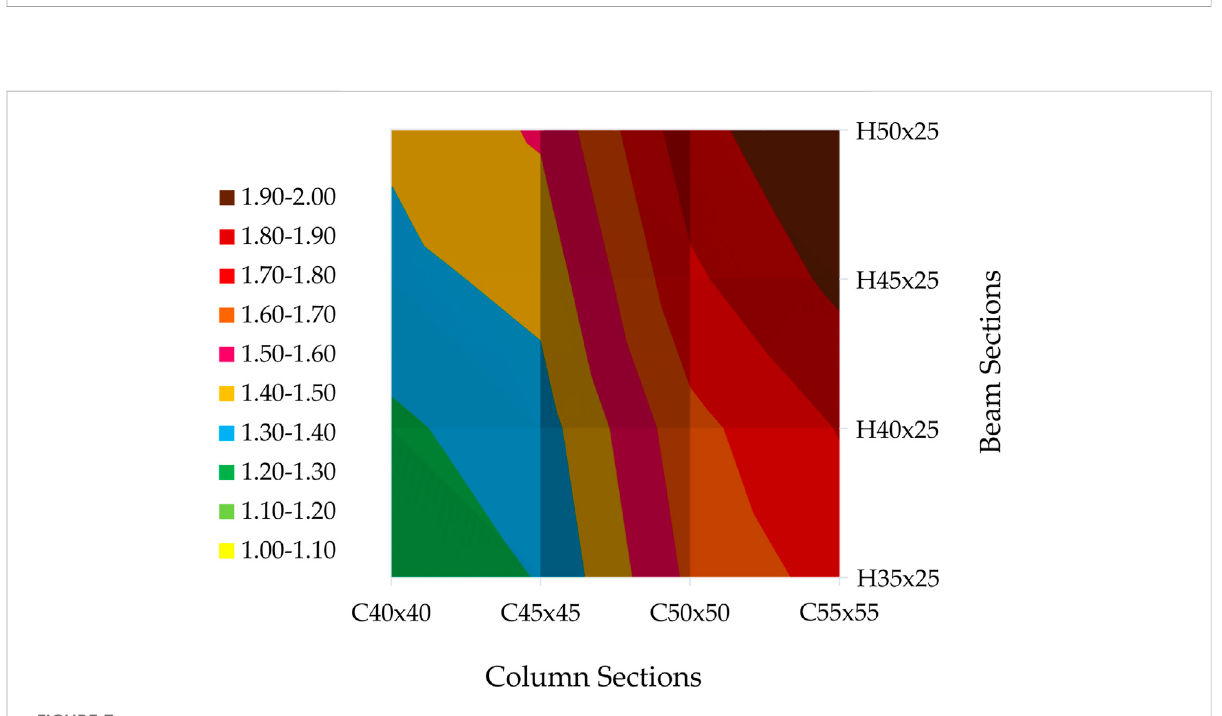
FIGURE 7 Cost index of hidden beam